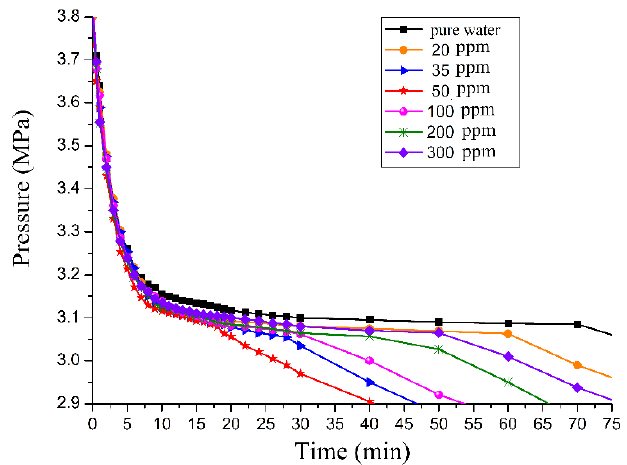
Figure 4. Observed pressure versus time trajectories showing CO 2 hydrate formation within initial 75 min.